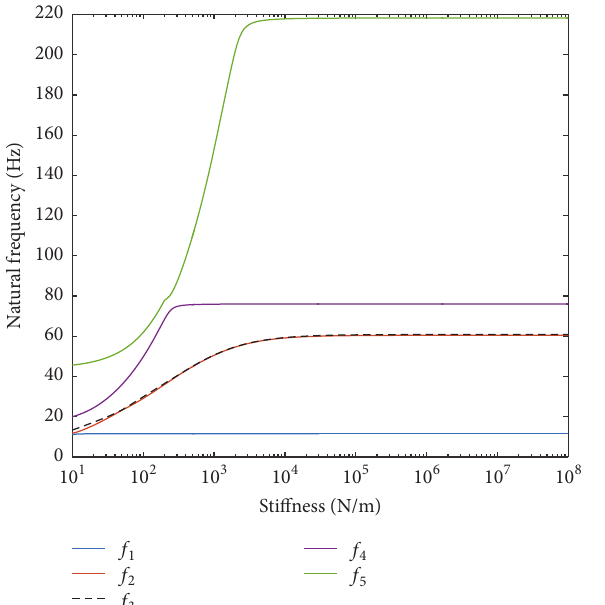
Figure 8: Variation of natural frequencies versus connection stiff- ness 𝑘 𝑙 .